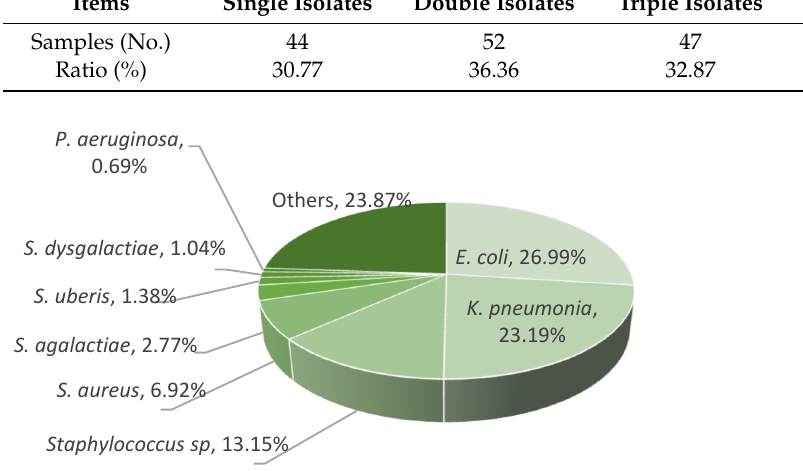
Figure 1. Analysis of 289 strains of pathogenic bacteria of bovine mastitis. All isolates were obtained and identified through bacterial isolation, purification, and 16S rDNA